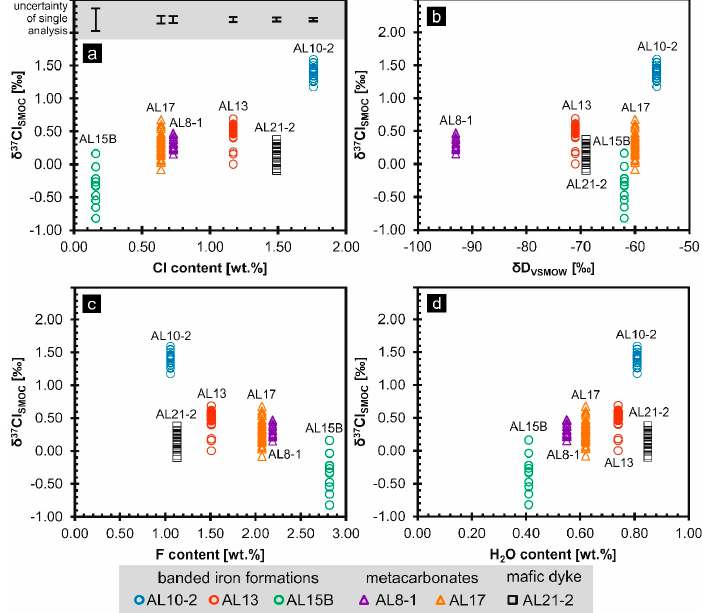
Figure 8. δ 37 Cl SMOC values of Isua apatite crystals measured by SIMS and shown in relation to the chlorine ( a ), fluorine ( c ), and H 2 O ( d ) abundances as well as compared to δ D VSMOW values ( b ) determined in the earlier study (Table 1). Error bars ( a ) show average uncertainty of single analysis determined for each sample, and they decrease from ±0.17 for Cl-poor fluorapatite AL15B to ±0.02 for Cl-rich hydroxylapatite AL10-2.